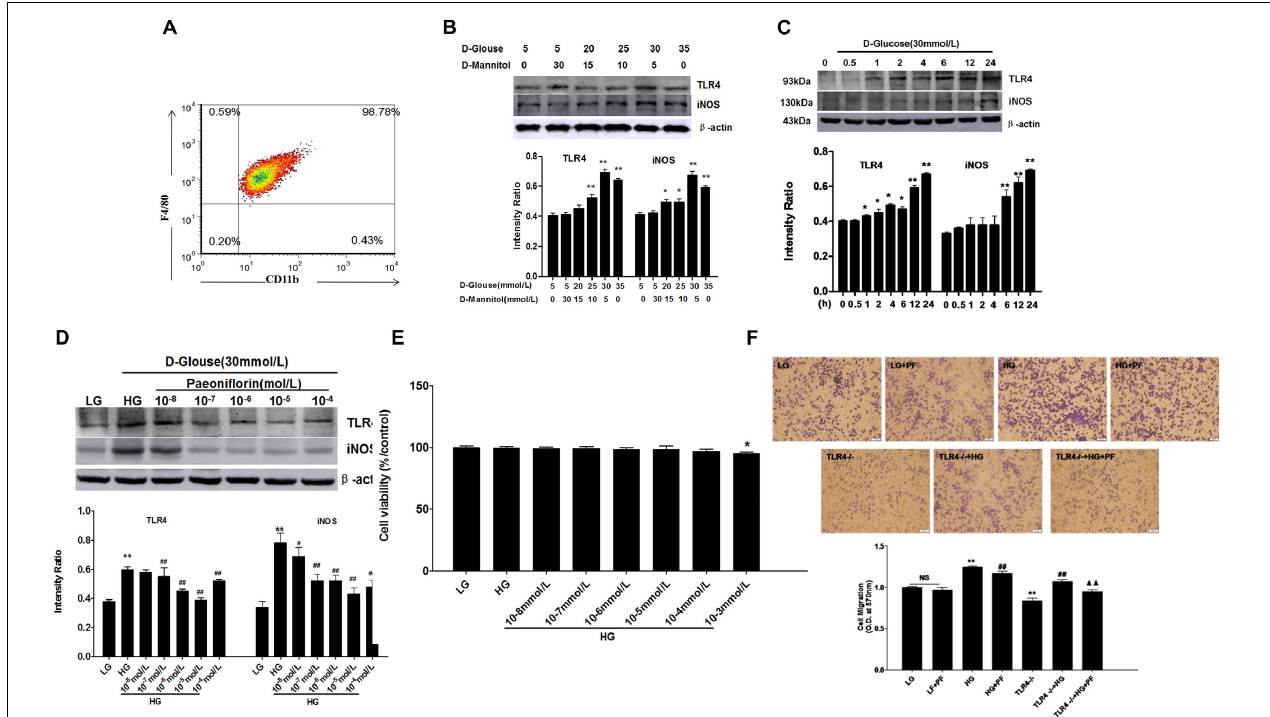
FIGURE 4 | Cellular experimental conditions. The optimal concentration and stimulation time of D-glucose and the optimal PF concentration were determined first. (A) Identification of BMDMs. (B) Effects of different high concentrations of glucose on TLR4 expression and BMDM activation. (C) Effects of high-glucose stimulation on TLR4 and BMDM activation at different time points. (D) Effects of various PF concentrations on TLR4 expression and BMDM activation. (E) Cell viability detected using a CCK-8-based assay. (F) Cell migration detected by the Transwell method. Values are expressed as the mean ± SD of at least three independent experiments. NS: not significant; ∗ P < 0.05 and ∗∗ P < 0.01 vs. the LG group; # p < 0.05 and ## p < 0.01 vs. the HG group; (cid:78) P < 0.05, (cid:78)(cid:78) P < 0.01 vs. the TLR4-/-+HG